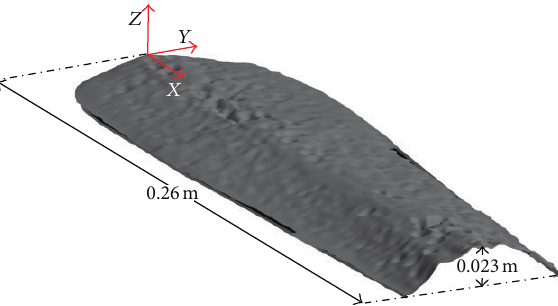
Figure 2: Upper surface geometry of the paddlefish rostrum, also showing location of reference coordinate